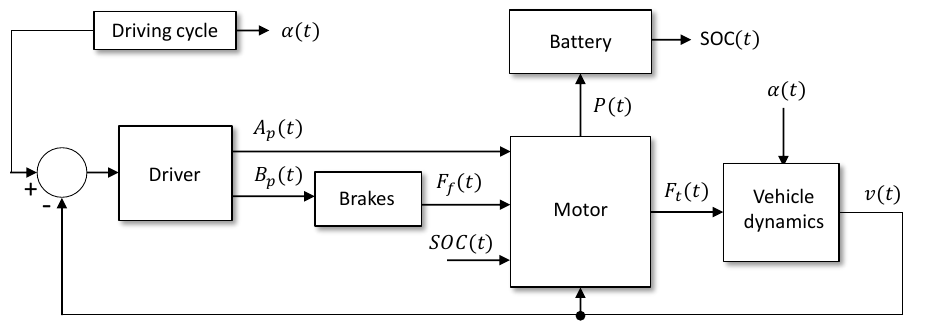
Figure 5. Model enhanced by component